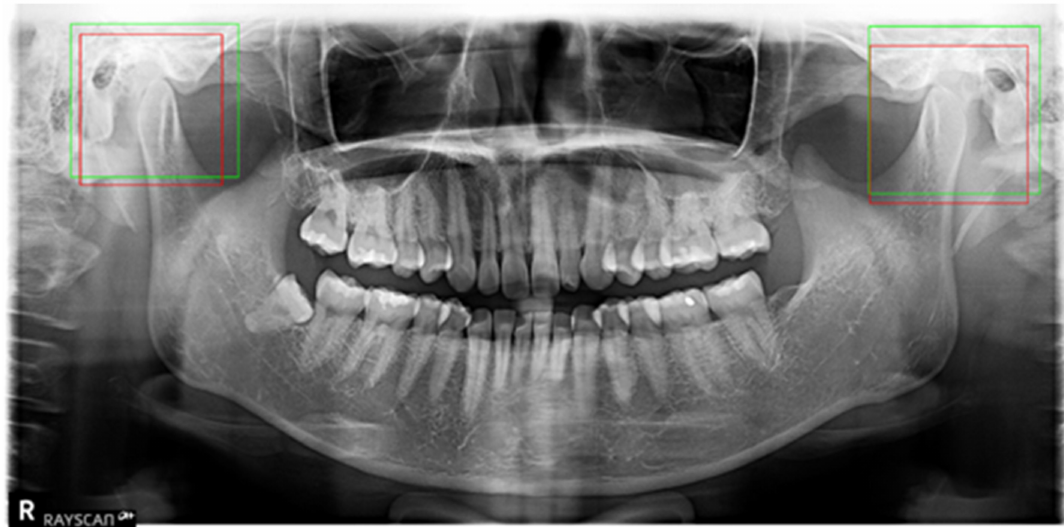
Figure 6. Condyle detection image example.